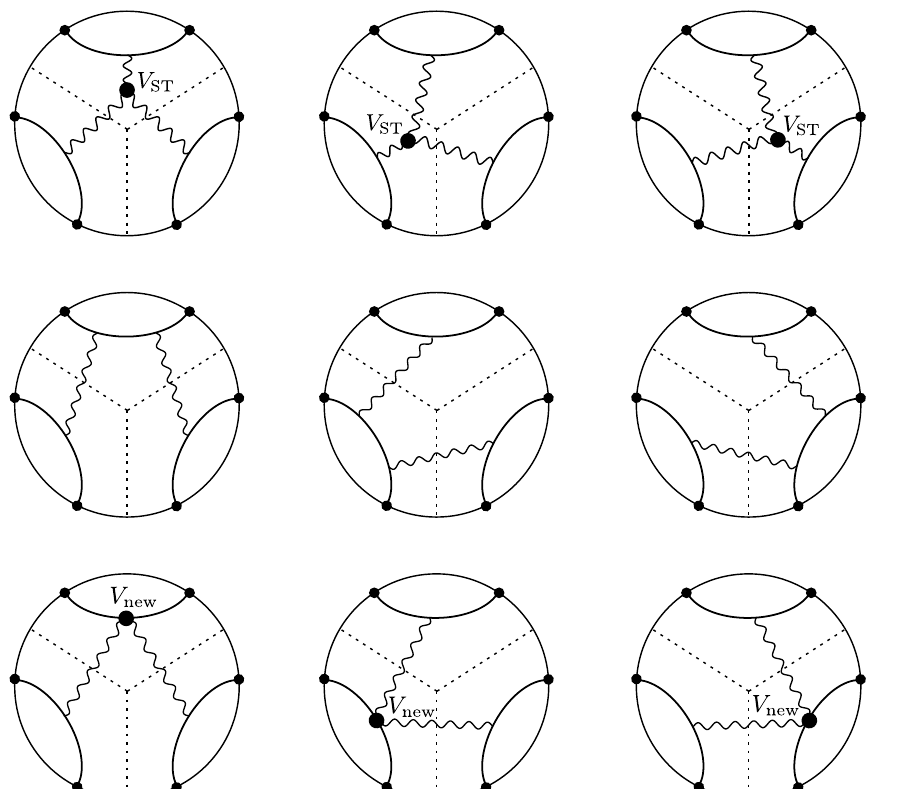
Figure 9 . The different terms in our procedure to “stitch together” the correlator of three bilocals out of bilocal-local-local correlators. In the regions that do not contain its worldline, each DV field can be viewed as a gauge-transformed superposition of boundary-bulk